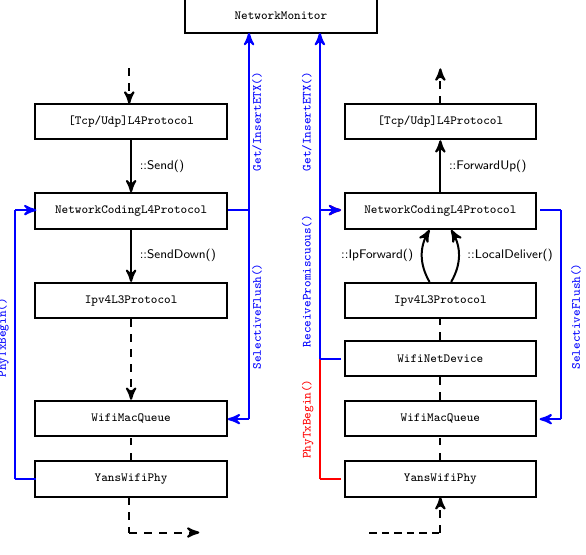
Figure 4: Transmission and reception/forwarding flow charts